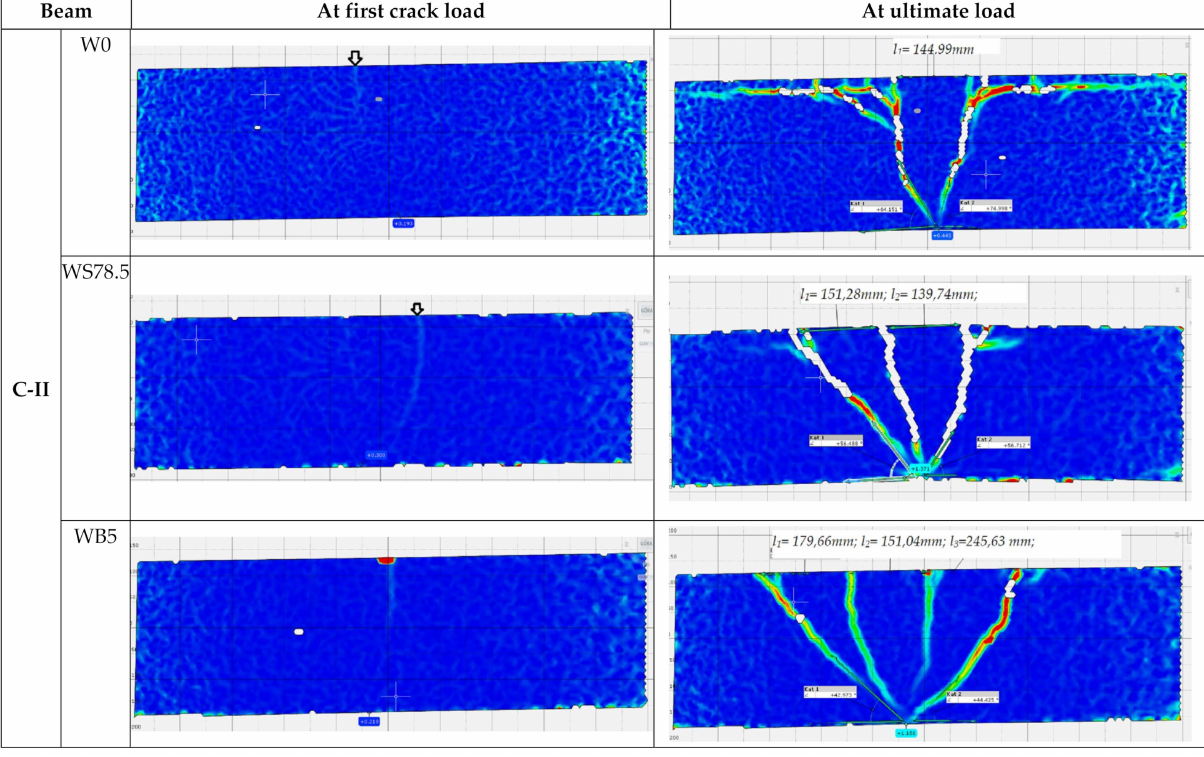
Figure 9. Principal strain contours in the center support in C-II series ( l is spacing between cracks in